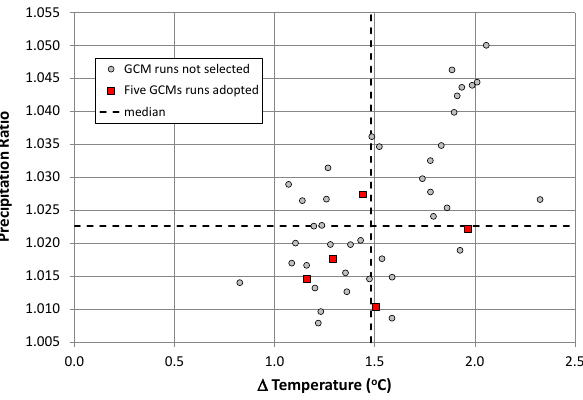
Figure 8. Ratio of 2015–2034 to 1965–1994 mean annual precipita- tion compared with the change in mean annual temperature (2015– 2034 to 1965–1994) for the selected five CMIP3 GCMs runs com- pared with the 23 CMIP3 GCMs including all ensemble members for the global land